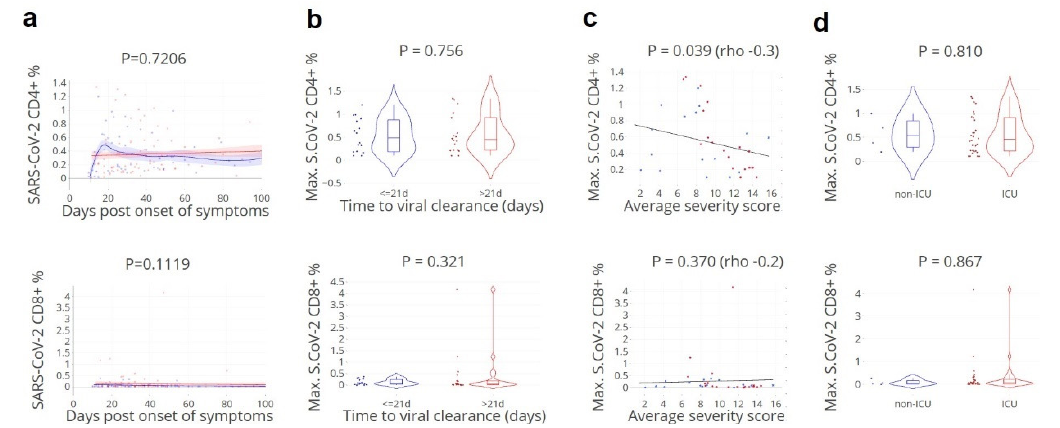
Figure 5. Lower SARS-CoV-2-specific CD4+ T cell counts correspond with higher disease severity . ( a ). Kinetics of circulating CD4+ and CD8+ T-cells specific to SARS-CoV-2 spike, nucleocapsid, and membrane peptides, in relation to the day of viral clearance. ( b ). Maximum values grouped by the time to viral clearance: ≤ 21 (blue)/> 21 (red) days. Lines indicate non-linear group trends. Spline regression with bootstrap confidence intervals. ( c ). Maximum values and average daily severity scores per patient, grouped by the time to viral clearance: ≤ 21 (blue)/> 21 (red) days. ( d ). Maximum values grouped by non-ICU (blue)/ICU (red) patients. SARS-CoV-2 CD4+ (%) = percentage of CD154+CD137+ out of total CD4+ T cells, SARS-CoV-2 CD8+ (%) = percentage of CD137+IFNg+ out of total CD8+ T cells. S.CoV-2; SARS-CoV-2. n = 34 patients, 130 samples. Mann–Whitney U test.